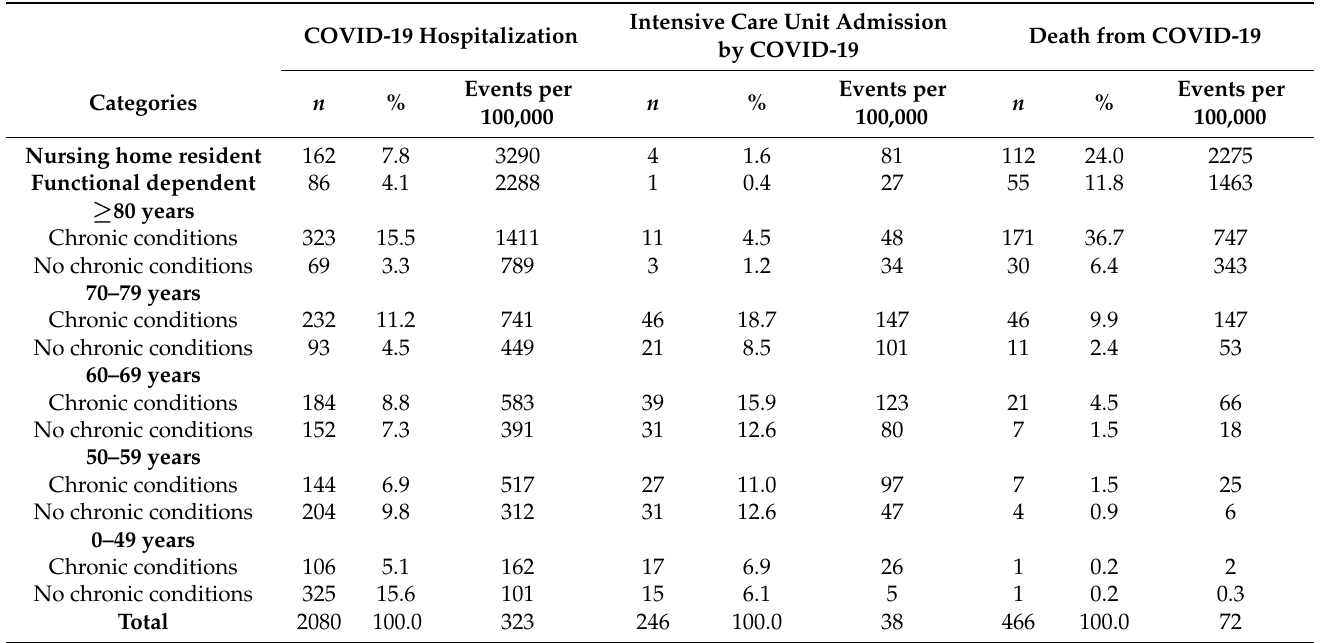
Table 5. Hospitalization, intensive care unit admission and deaths from COVID-19 in hierarchical categories for COVID-19 vaccination priority in the general population cohort ( n = 643,757). Figures presented are the number, proportion (%) of all events and events per 100,000